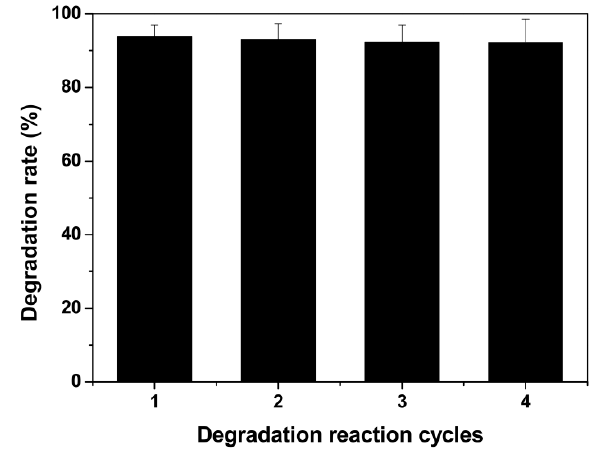
Figure 8. Continuous four-round degradation of CIP by the BMO composites.